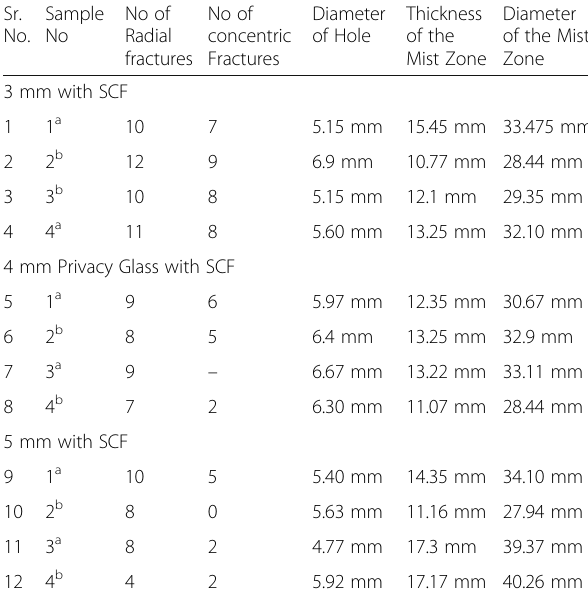
Table 3 Measurements for the Glass panes coated with the Sun Control Film (SCF)